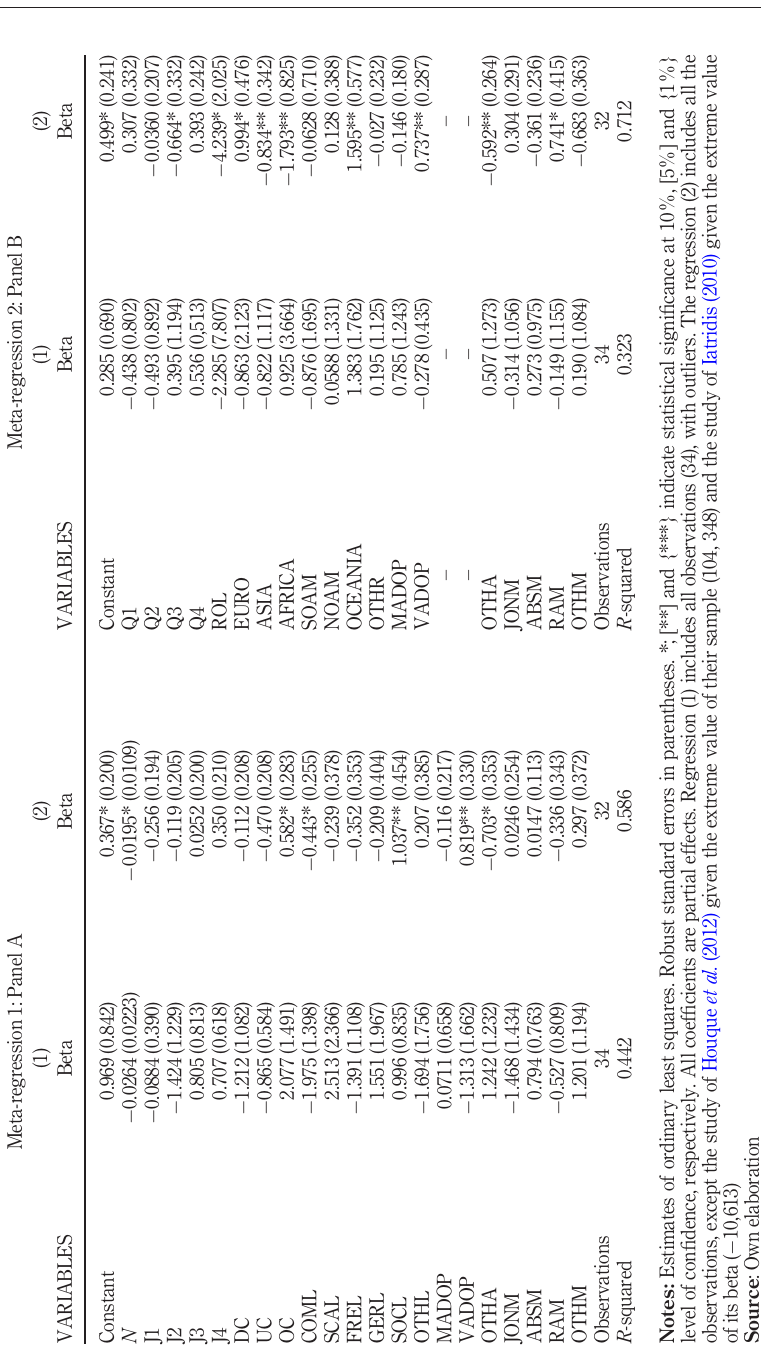
Table 2. Meta-Regressions 1 and